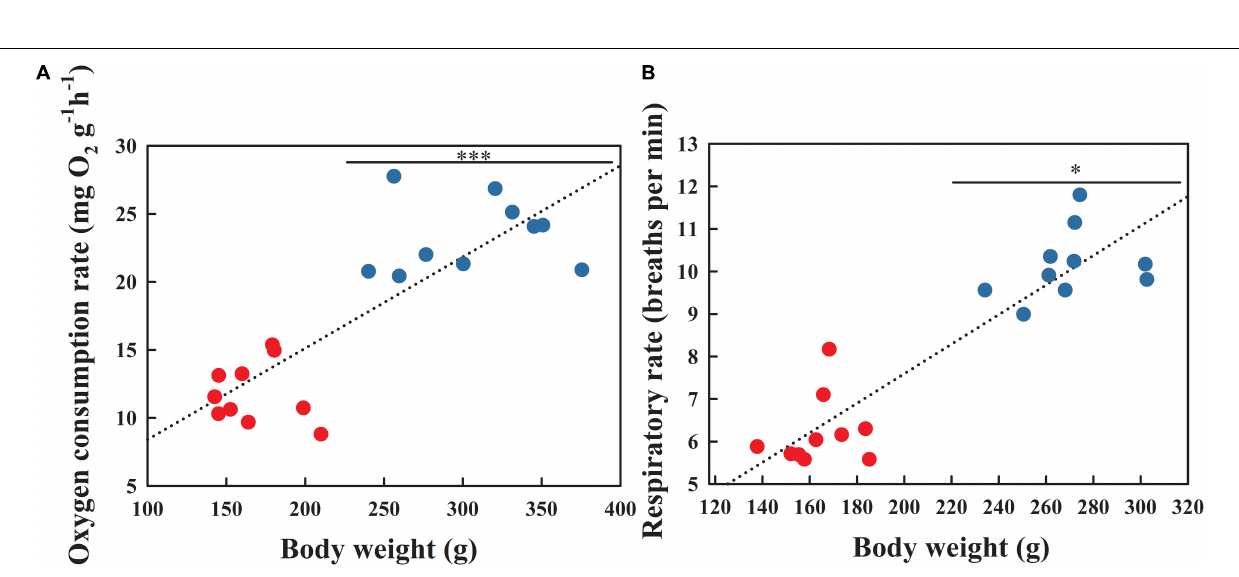
Frontiers in Physiology |